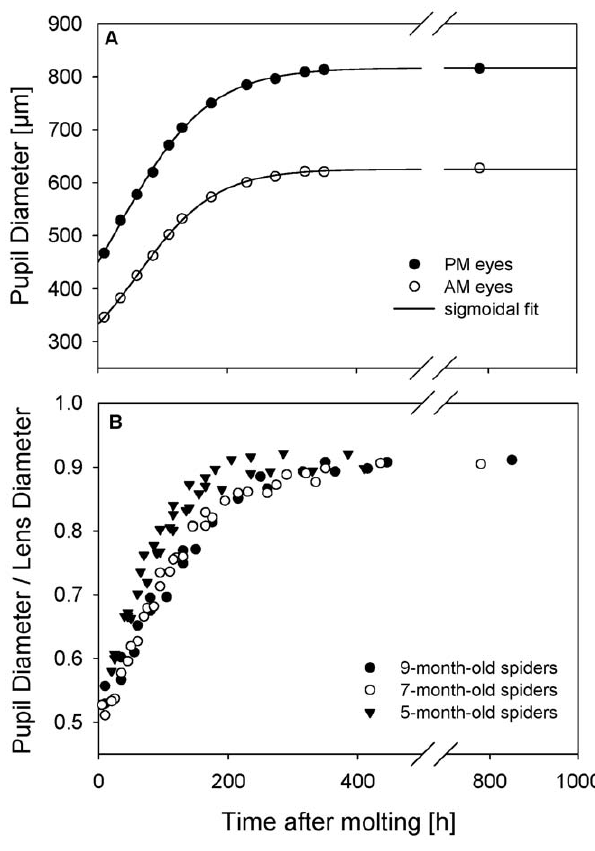
Figure 1. The pupil size as a function of time. (A) The mean pupil diameters of the PM and AM eyes for a 7-month-old spider as a function of the time after ecdysis. The data were fitted using d = d f – a /(1 + exp(( t – t 0 )/ b )), where d is the pupil diameter and d f is its asymptotic value for large times t . PM eyes (r 2 =0.9993): d f =817 m m, a =600 m m, t 0 =32 h, b =69 h. AM eyes (r 2 =0.9997): d f =626 m m, a =400 m m, t 0 =61 h, b =60 h. (B) The pupil-to-lens ratios of the PM eyes of Cupiennius salei , for three different age groups as a function of the time after ecdysis.